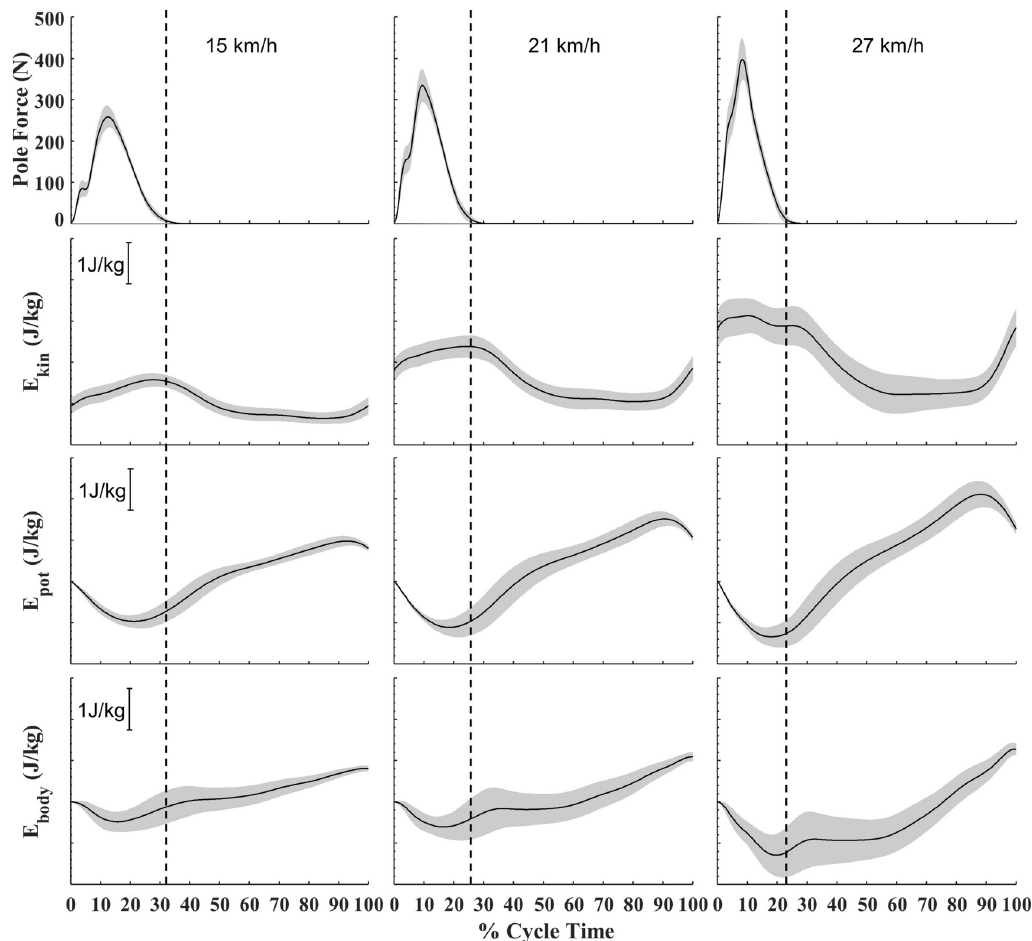
Fig 1. Pole force and mechanical energy during double poling at increasing speeds on a 1% inclined treadmill. Plots are the average of all subjects [N = 14] with 95% CI indicated with shaded areas. Dashed vertical lines represent end of poling phase (mean of all subjects). Energy are shown normalized to body weight, with unit indicated by vertical bars. E pot and E body are presented relative to the energy levels at the start of a